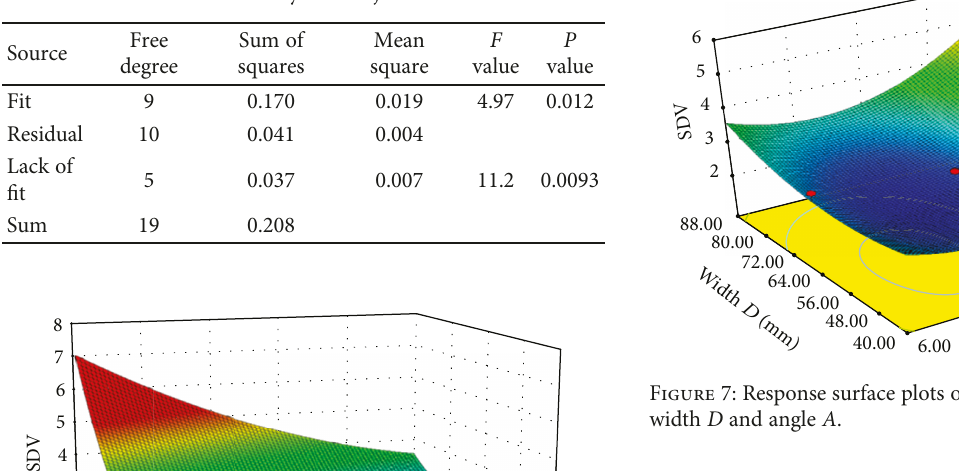
Table 7: Variance analysis of objective functions.